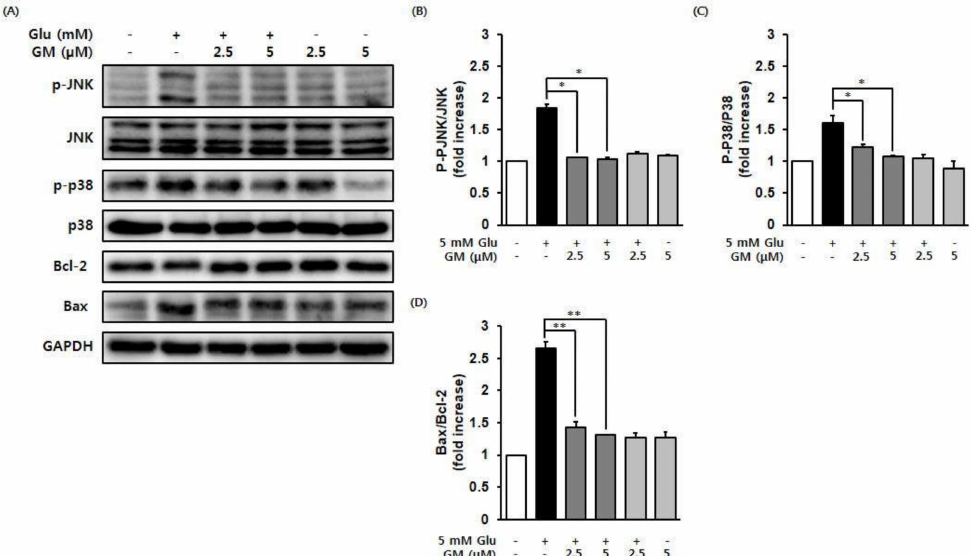
Figure 4. γ -mangostin (GM) inhibits the glutamate (Glu)-induced increase in the phosphorylation of MAPK and the Bax/Bcl-2 ratio. Cells were incubated with 5 mM Glu and 2.5 or 5 µ M GM for 6 h. ( A ) The immunoreactive bands were detected with specific antibodies against p-JNK, JNK, p-p38, p38, Bcl-2, Bax, and GAPDH. ( B , C ) Bars denote the relative increase of phosphorylation of JNK and p38, respectively (mean ± S.E.M., * p < 0.05 and ** p < 0.01 compared with glutamate-treated cells). ( D ) The graph represents the ratio of Bax to Bcl-2 protein expression (mean ± S.E.M., ** p < 0.01 compared with glutamate-treated